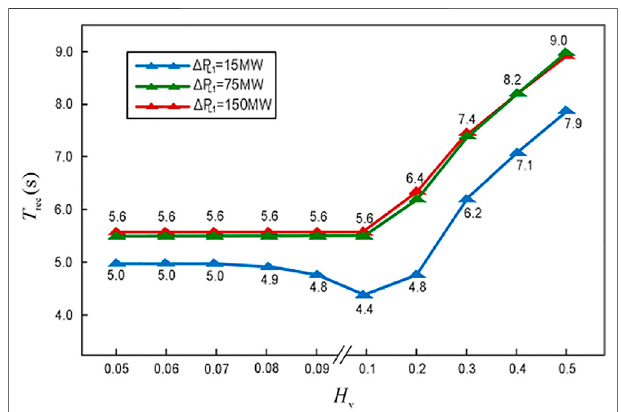
FIGURE 13 | Variations in T rec with respect to H v .